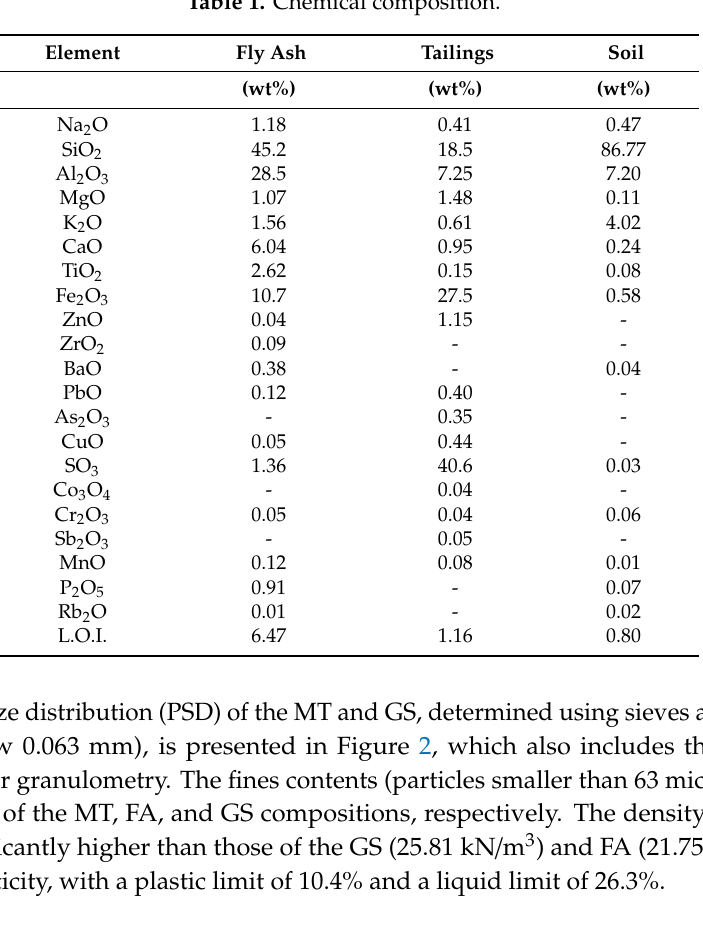
Table 1. Chemical composition.